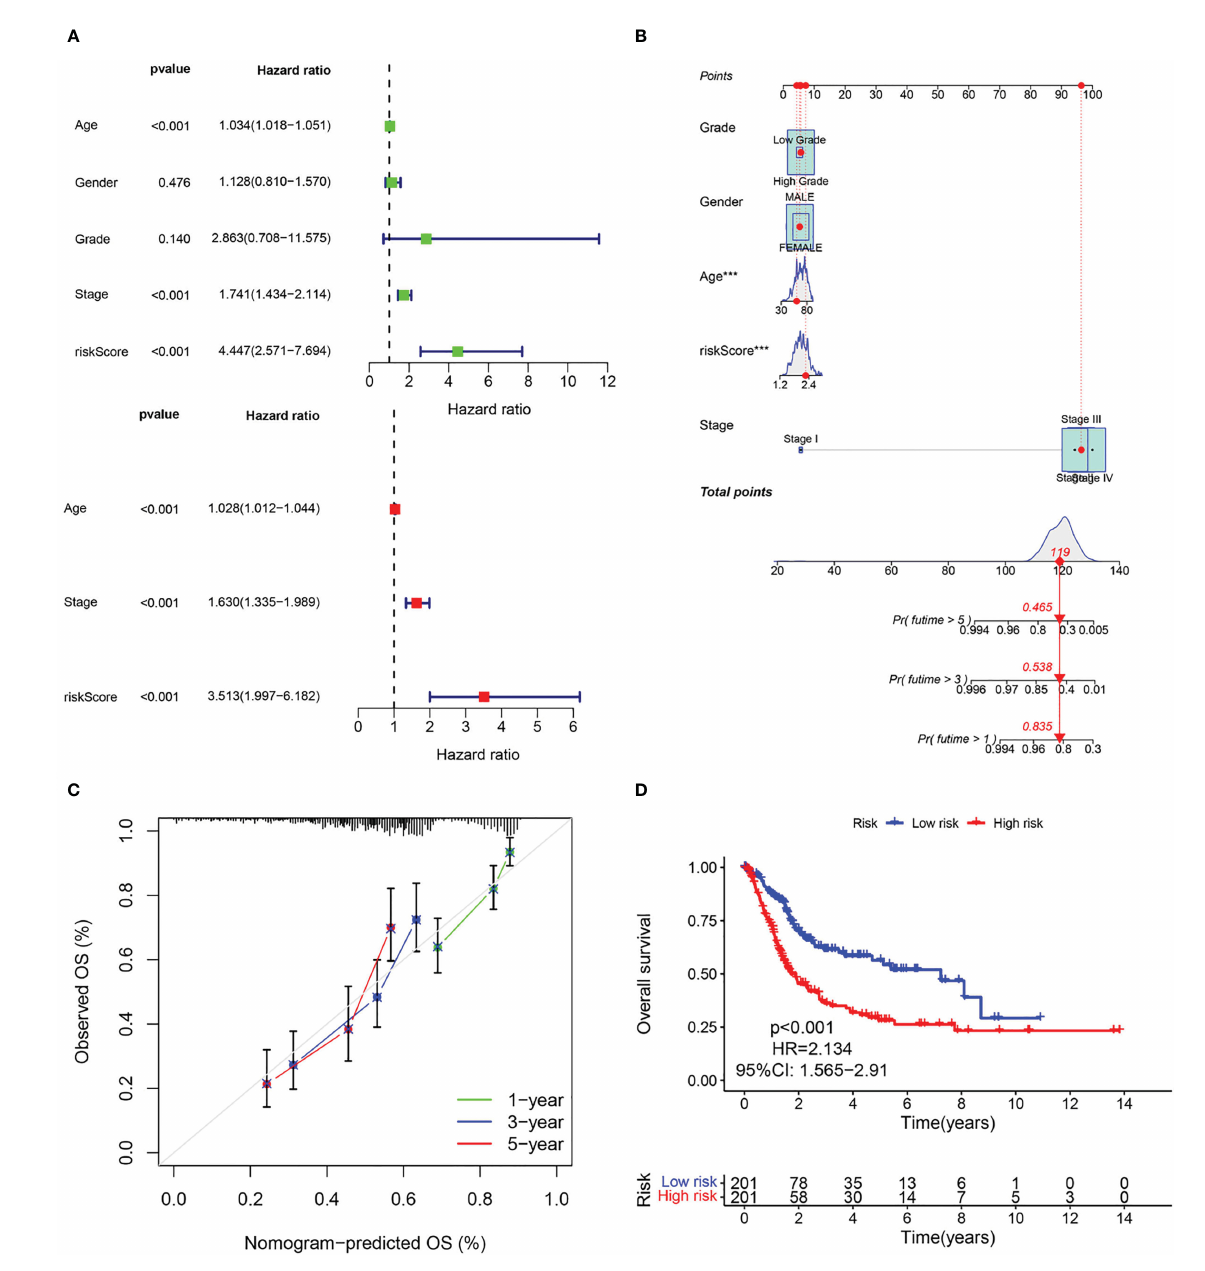
FIGURE 7 Evaluation of the predictive capability of CAF signature based the TCGA cohort. (A) Forest maps of the univariate and multivariate Cox regression analysis between the CAF-riskScore and clinical characteristics. (B) Nomogram predicting the survival rate at 1, 3, 5 years for BLCA patients, and ***p< 0.001. (C) Calibration plots for the nomogram. (D) Kaplan – Meier survival curve for the CAF-risk